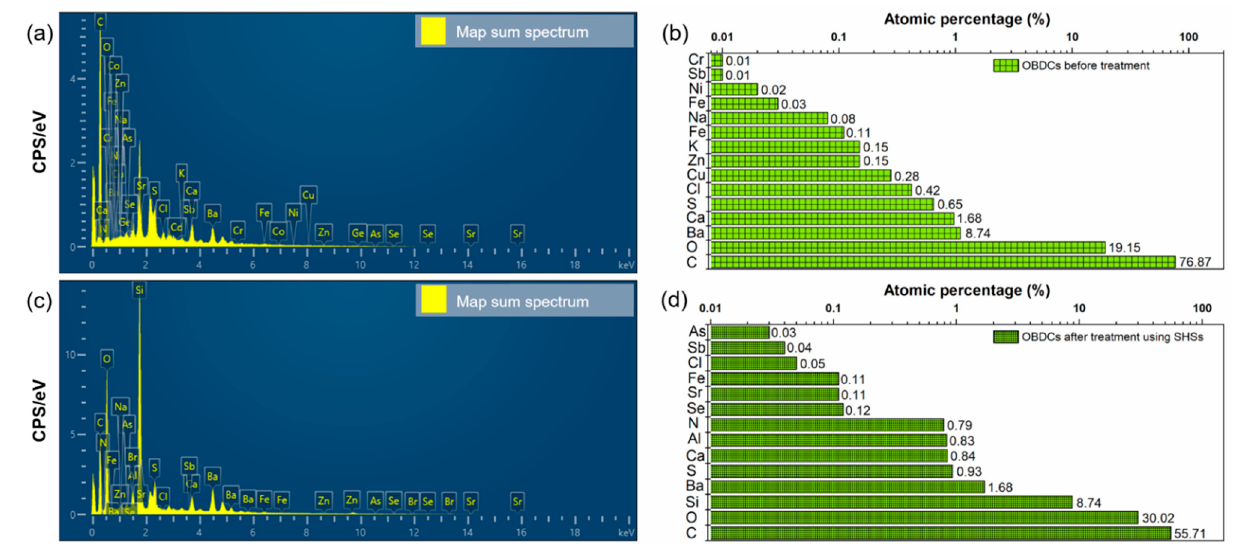
Figure 11. EDS elemental map sum spectrums and atomic percentages of shale gas OBDCs before ( a , b ) and after ( c , d ) treatment by using SHSs.